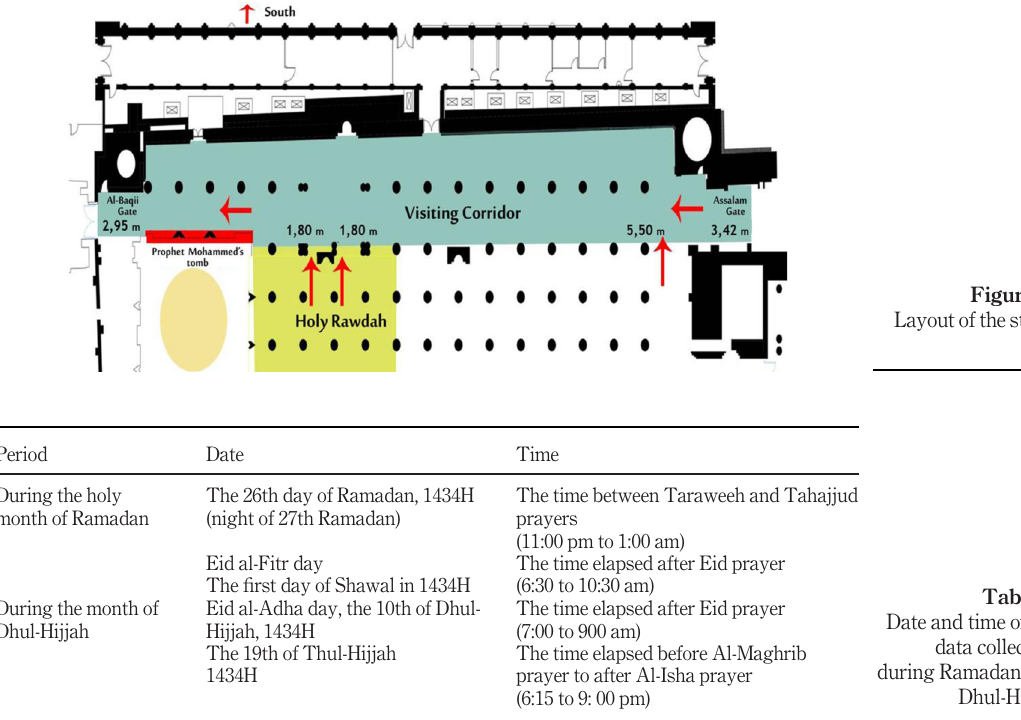
Table I. Date and time of